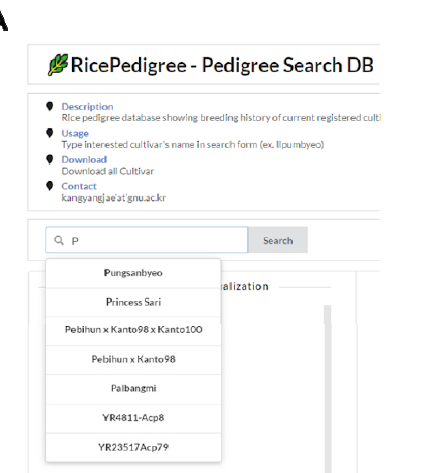
Figure 3. The interface of the RicePedigree web page. ( A ) Search panel recommends possible acces‑ sion names based on the first few input letters. ( B ) Pedigree tree visualization panel shows parental lines from the database. ( C ) Pedigree search result panel shows a list of cultivars or breeding lines that contain the query in their breeding